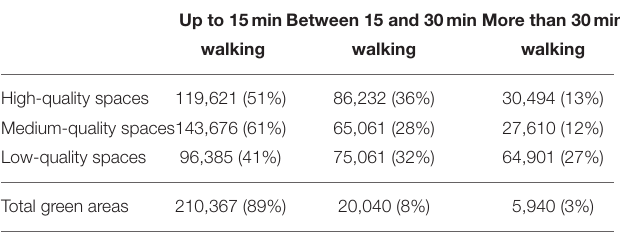
TABLE 2 | Population with access to urban green spaces in Talca, considering a total of 220,400 inhabitants. Up to 15min Between 15 and 30min More than 30min walking walking walking